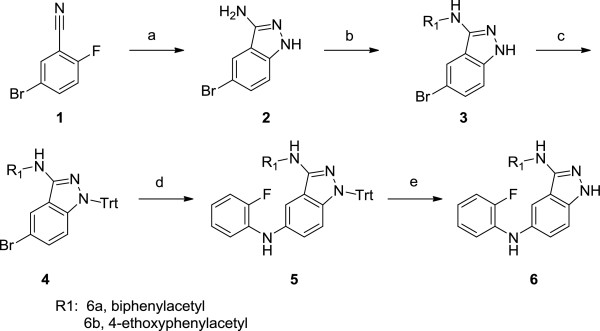
Synthetic scheme for compound 6a and 6b. Reagents and experimental conditions: a) H2NNH2, n-BuOH, reflux, b) i) 4-C2H5OC6H4CH2COCl (or 4-PhC6H4CH2COCl), THF, reflux, ii) 2N NaOH, c) TrtCl, K2CO3, CH3CN, reflux, d) 2-FC6H4NH2, Pd2(dba)3, (R)-BINAP, NaOBu-t, toluene, reflux, e) TFA:Phenol:H2O:TIPS (88:5:5:2), DCM.